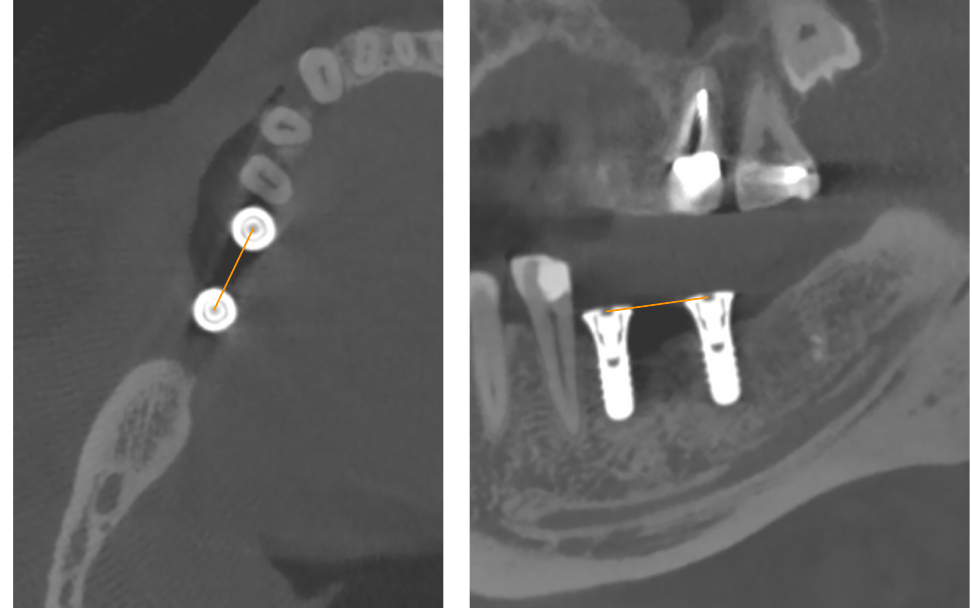
Figure 1. Horizontal linear measurements from the center of one implant healing cap to another (i.e., inter-implant distance) on CBCT axial and sagittal views.